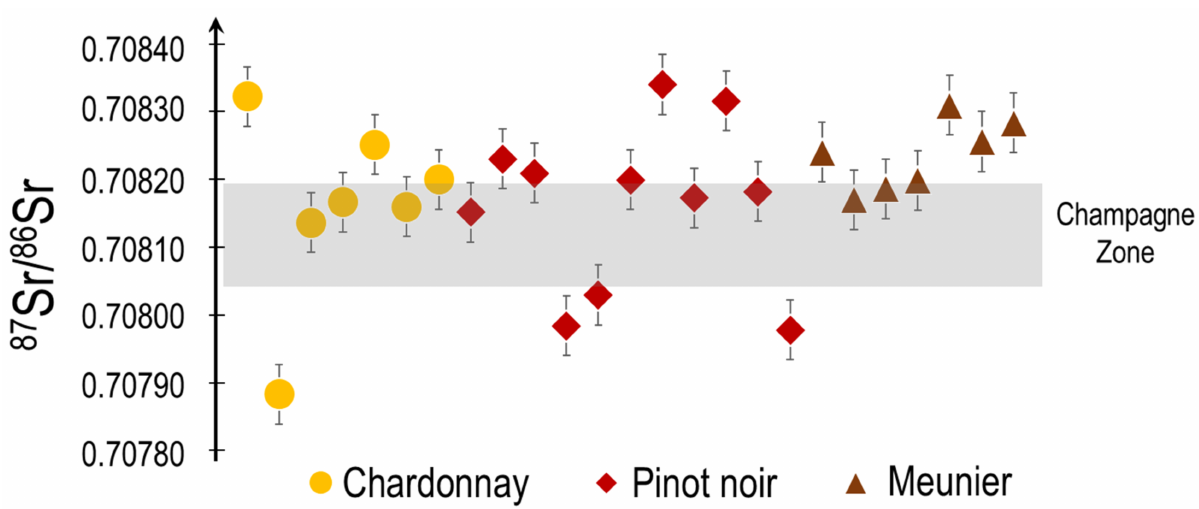
Figure 4. 87 Sr/ 86 Sr ratio of musts produced from three grapevine varieties in Champagne the average ratio in Champagne ± 2 σ . Errors bars (2 σ ) are from triplicate